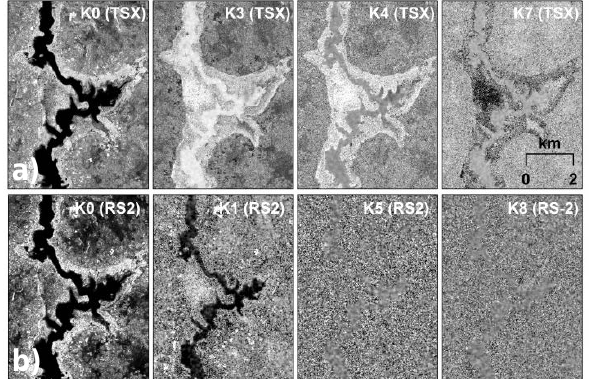
Figure 2. Kennaugh elements deducted from (a) TerraSAR-X dual-co-pol HH-VV data: K 0 , K 3 , K 4 , and K 7 (top row), and (b) RADARSAT-2 dual-cross-pol HH-HV data: K 0 , K 1 , K 5 , K 8 (bottom row). Both images were acquired on 18 October